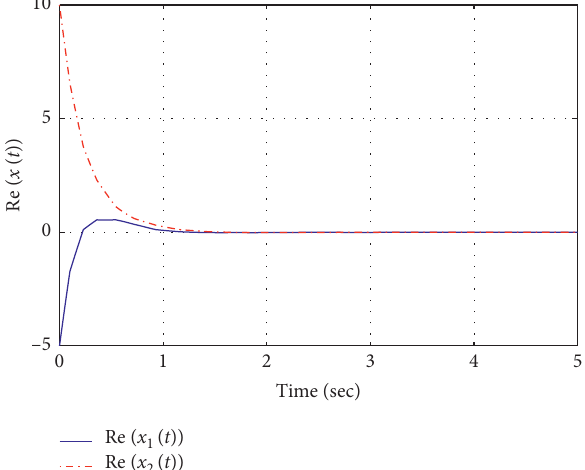
Figure 10: Responses the state of the real part.